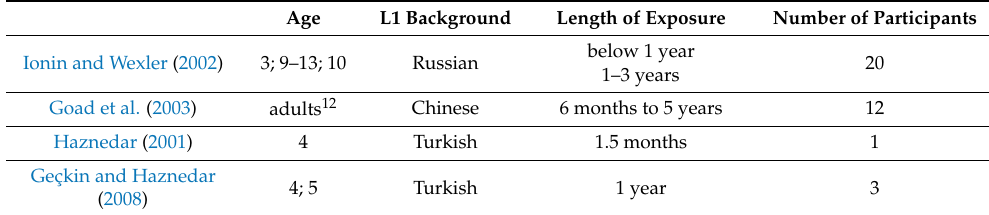
Table 4. Previous L2 English studies (naturalistic spoken